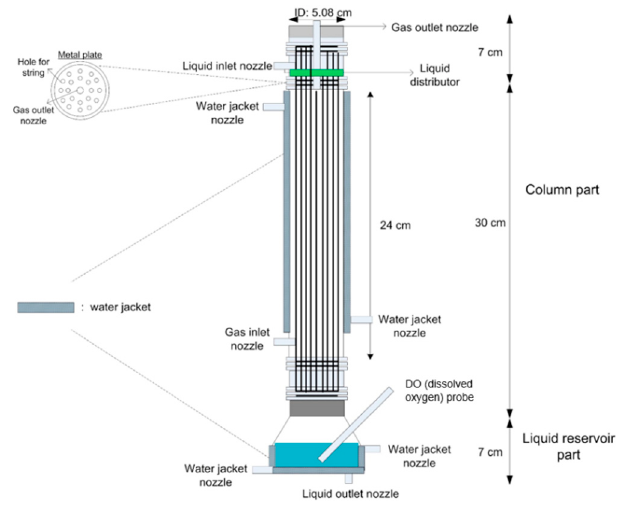
Figure 6. Schematic diagram of the string film reactor.